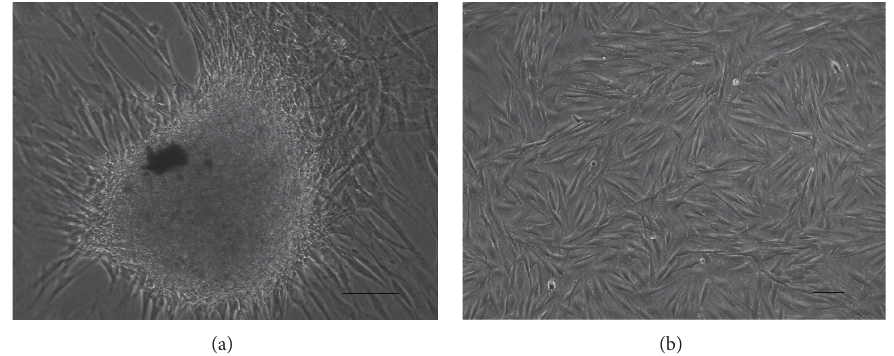
Figure 1: Cultivation and expansion: (a) primary cultured REMSCs at 5 days; cells migrated from the explants and attached to the culture plate. (b) Rat REMSCs at 4th passage demonstrated large and flat cell morphology. Bar: 50 𝜇 m for all pictures.